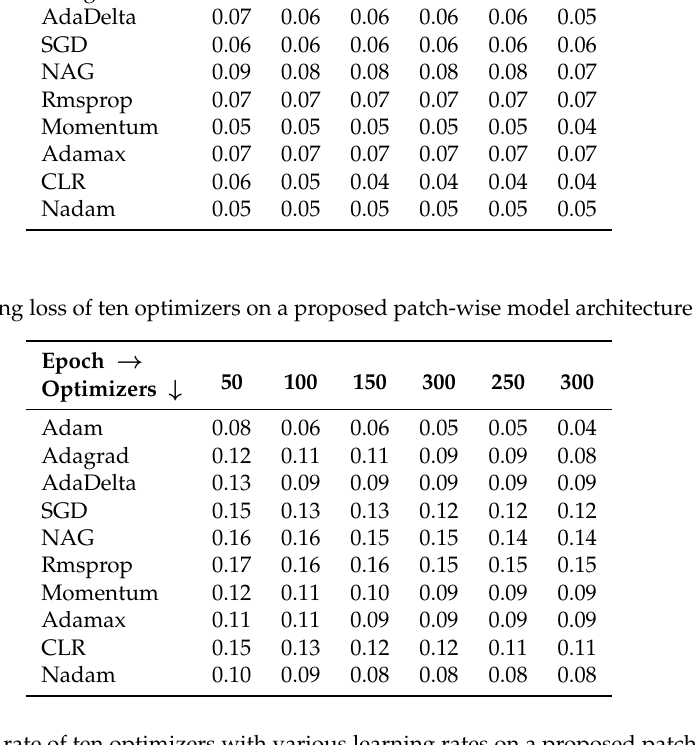
Table 9. Accuracy rate of ten optimizers with various learning rates on a proposed patch-wise model architecture of